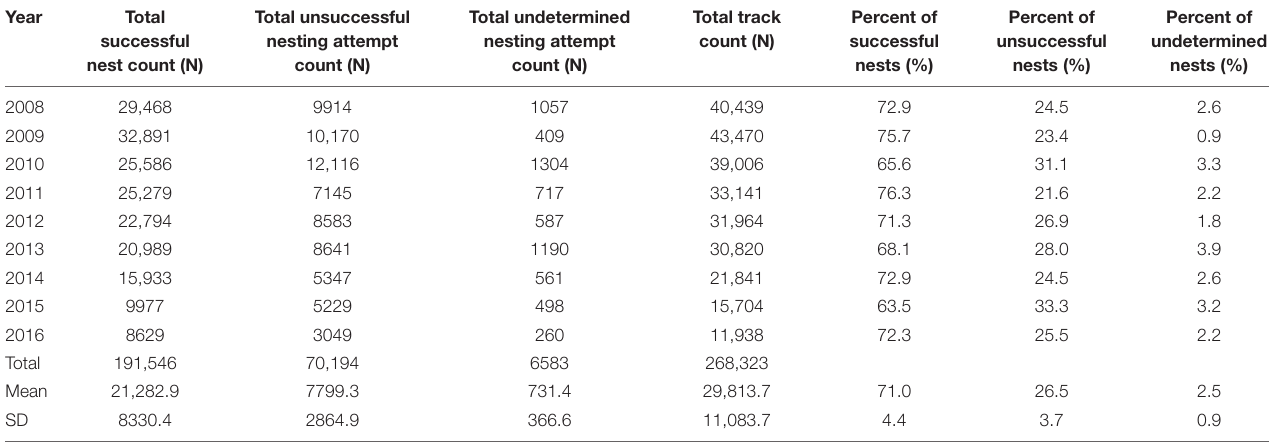
TABLE 3 | Summary of nesting success surveys for K0–K22 for 2008–2016, including ratios of successful, unsuccessful, and undetermined nests in comparison to the track count total.